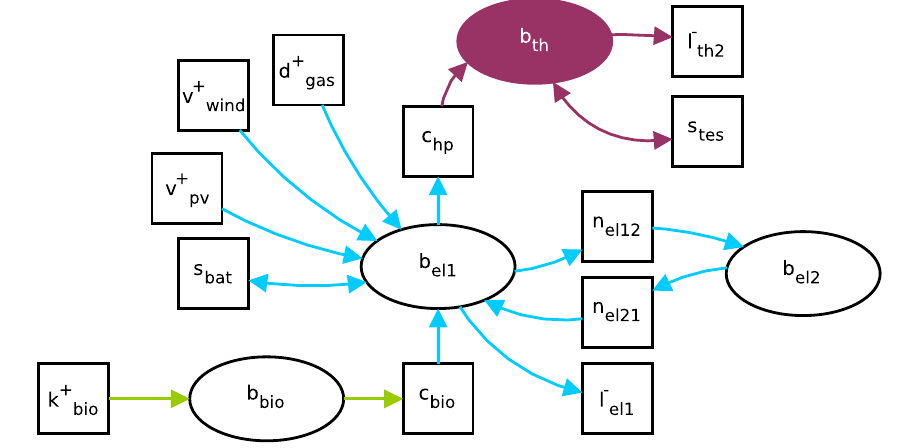
Figure 1. Illustration of a sector coupled energy system modelled based on oemof tabular. The energy system is modelled as a bi-partite graph with components (squares) and buses (ellipses). Electricity flows are coloured blue, biomass green and heat